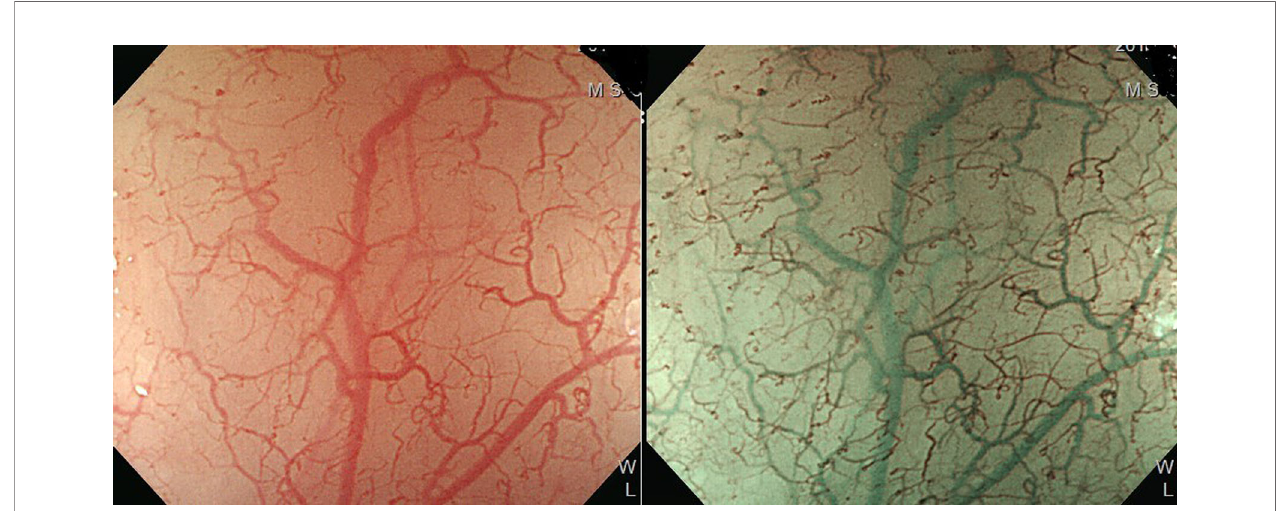
FIGURE 4 | Improved visualization of microvascular structure under narrow-band imaging endoscopy ( Left : conventional white-light imaging. Right : narrow-band